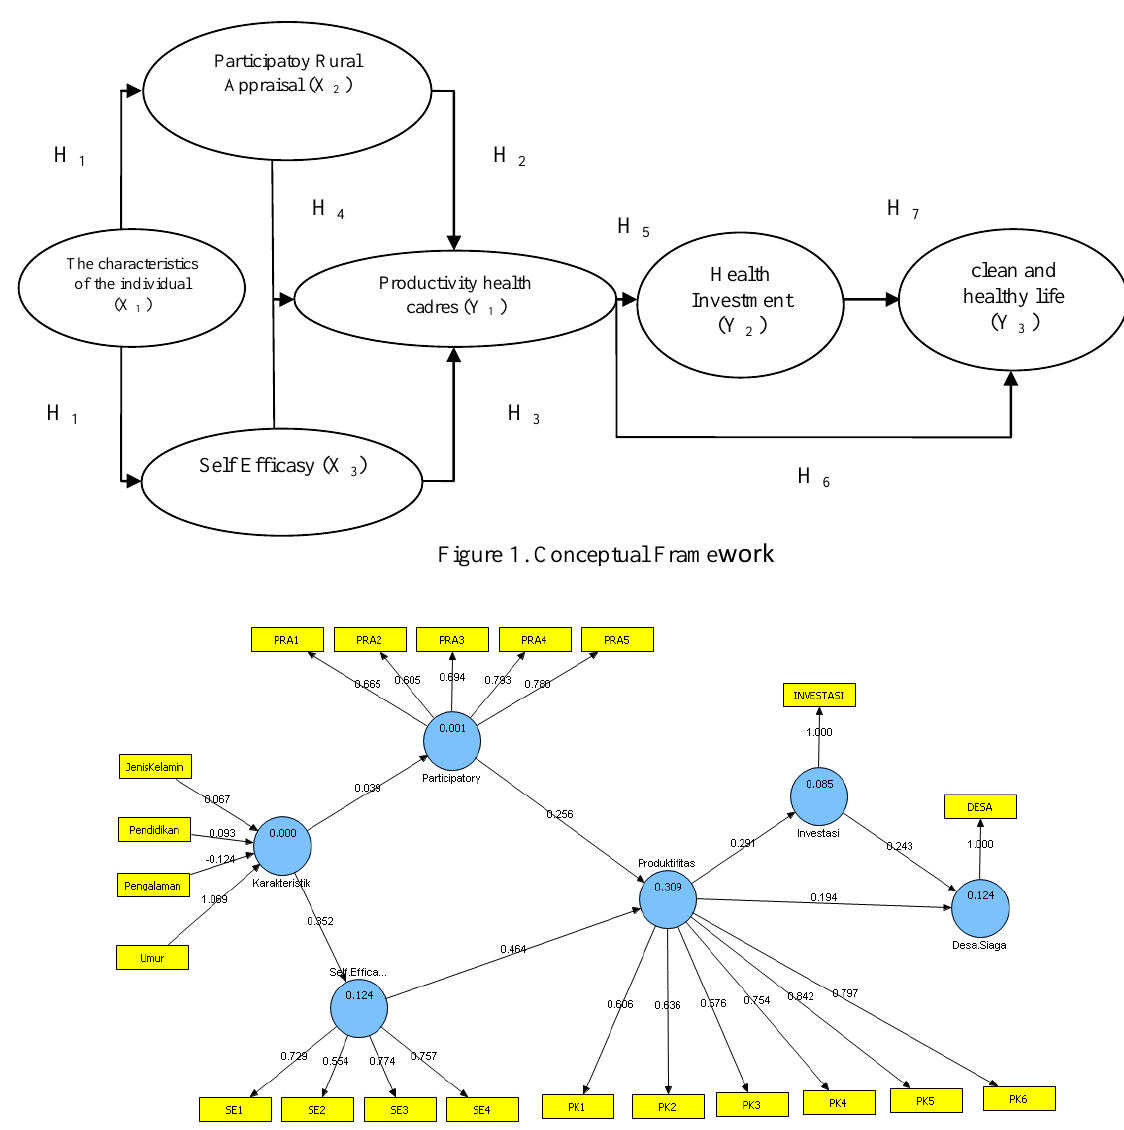
Figure 2. The results of the hypothesis